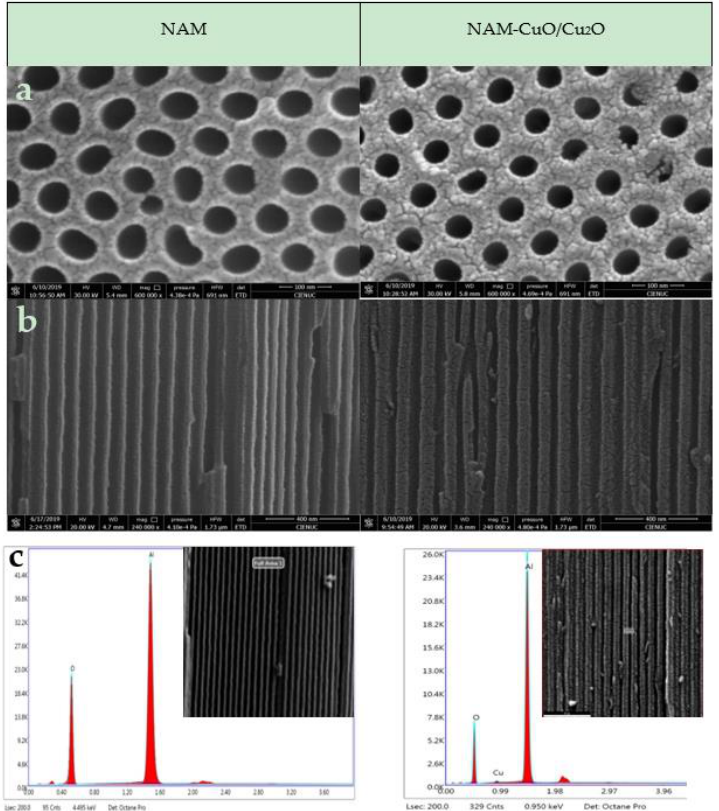
Figure 5. SEM images of the NAM and NAM-CuO/Cu 2 O of ( a ) top surface and ( b ) edge view. ( c ) X-ray spectroscopy analysis.